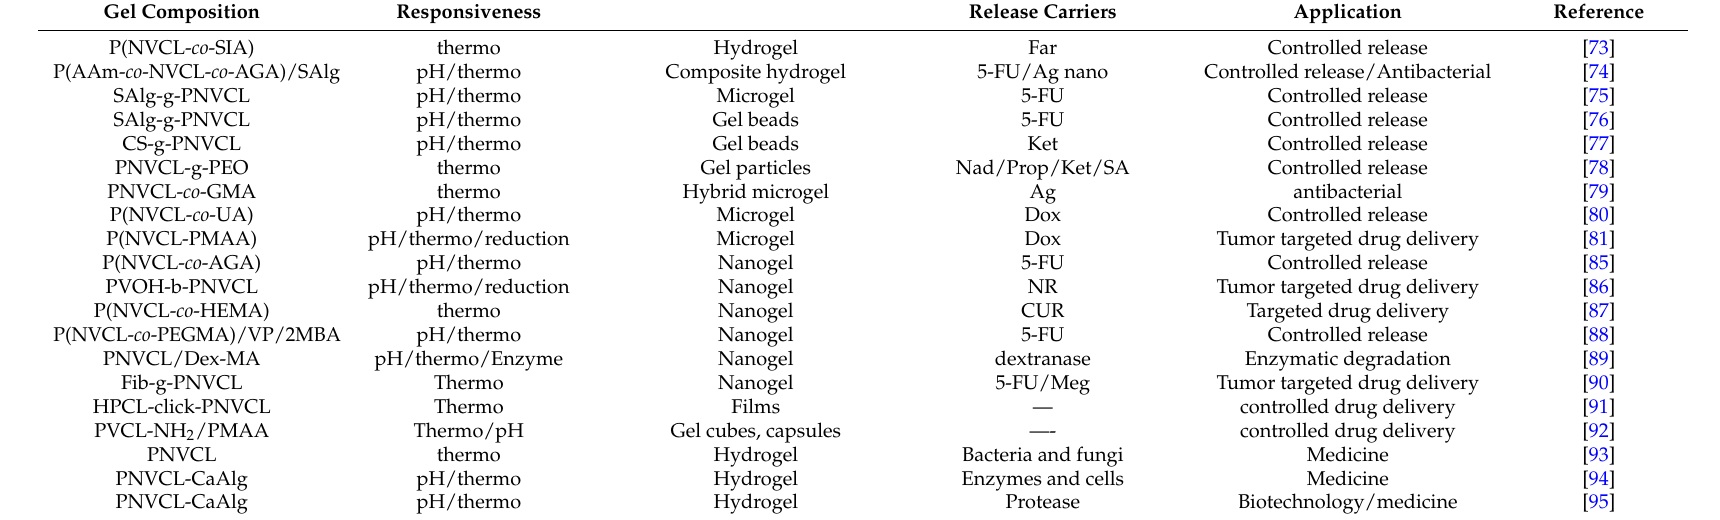
Table 1. Summary of the recent significant studies on the stimuli responsive gels of poly( N -vinyl caprolactam) PNVCL for biomedical